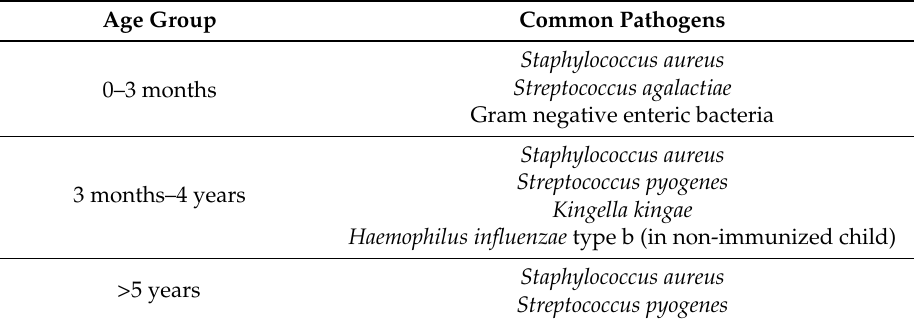
Table 3. Age-specific etiologic agents of pediatric acute